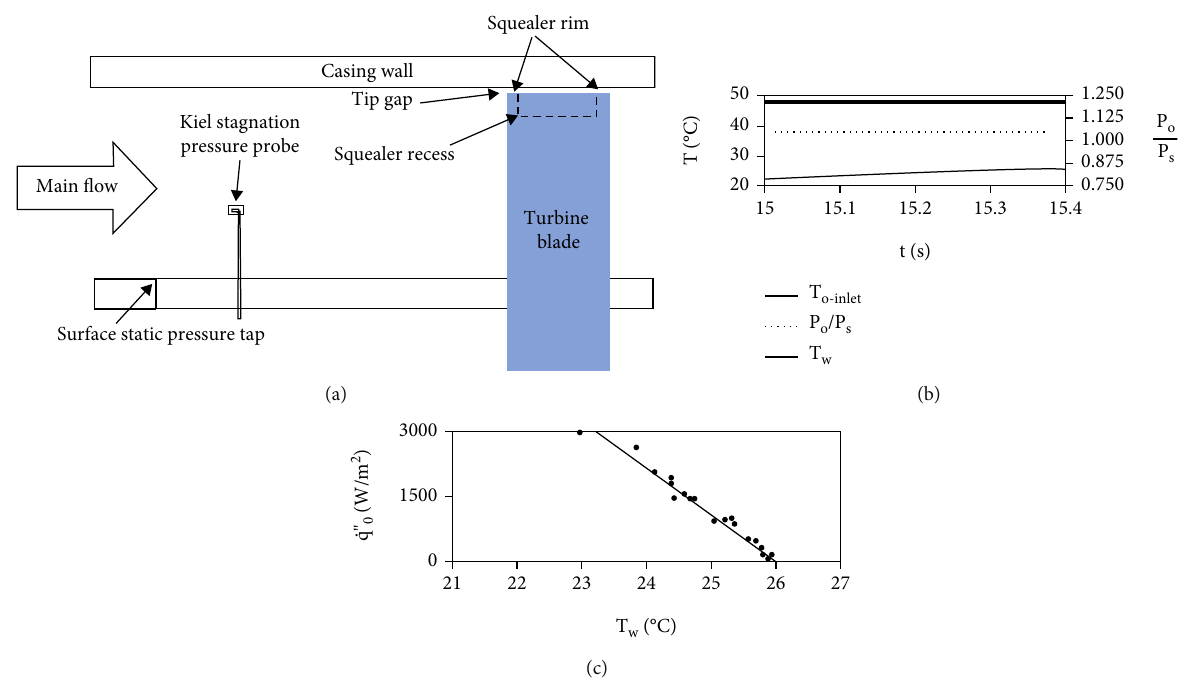
Figure 3: (a) Details of A1 fi lm-cooled blade. (b) Variations of inlet stagnation temperature and ratio of total pressure to static pressure within the mainstream fl ow and variation of surface temperature at one location along the camber line within the squealer recess during a typical blowdown test for the dataset 2020-06-26-2025-c21. (c) Variation of local surface heat fl ux with surface temperature during a typical transient test at one location along the camber line within the squealer recess for the dataset